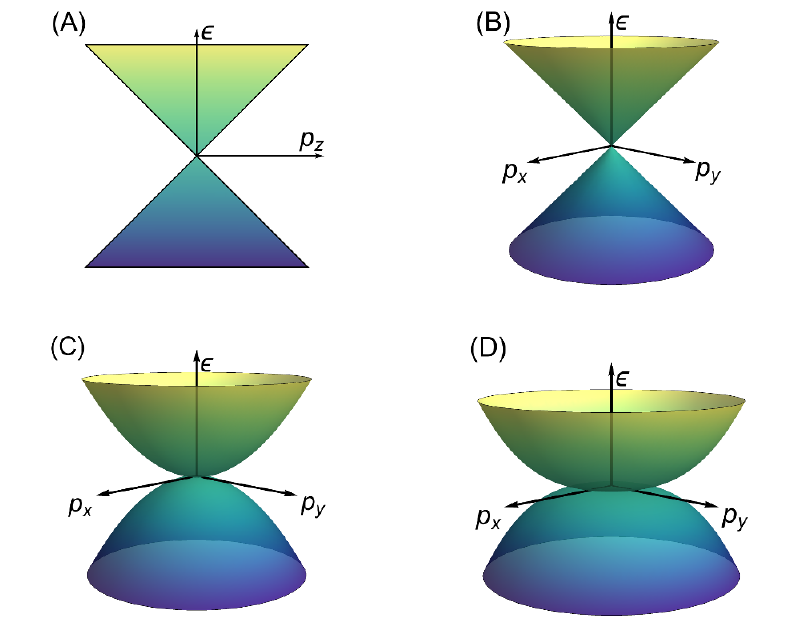
Figure 1 . Quasiparticle spectra in a multi-Weyl system along various high-symmetry directions in the close vicinity of Weyl nodes, characterized by an integer monopole charge n . Note that dispersion always scales linearly with p energy scales as E (cid:24) j p ? j for n = 1 (see panel B), E (cid:24) j p ? j 2 for n = 2 (see panel C) and E (cid:24) j p ? j 3 for n = 3 (see panel D), where p ? = p x (cid:0) p y plane. Here, momentum p = ( p x ; p y ; p z ) is measured from the Weyl node. Note that for n > 1 the system looses the Lorentz